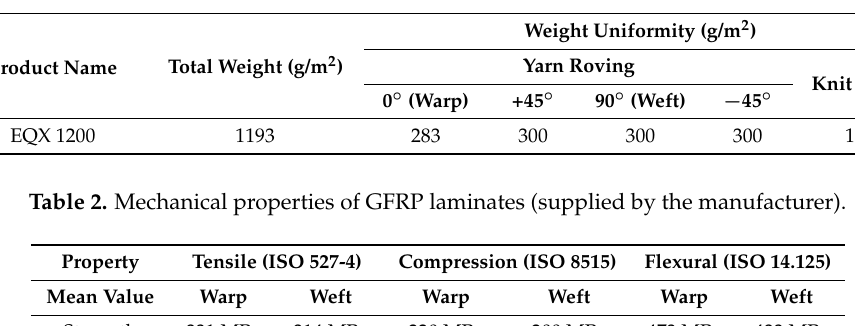
Table 1. Glass fiber-reinforced polymer (GFRP) laminate properties of EQX1200 (supplied by the manufacturer).